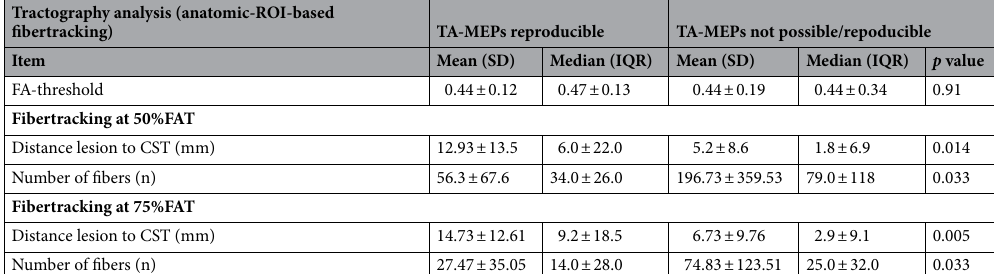
Tractography analysis (anatomic-ROI-based fibertracking) TA-MEPs